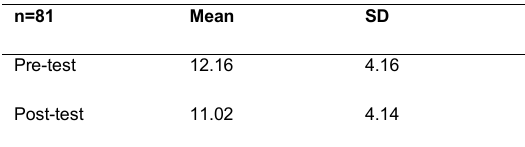
Table 2 Comparison of differences of external